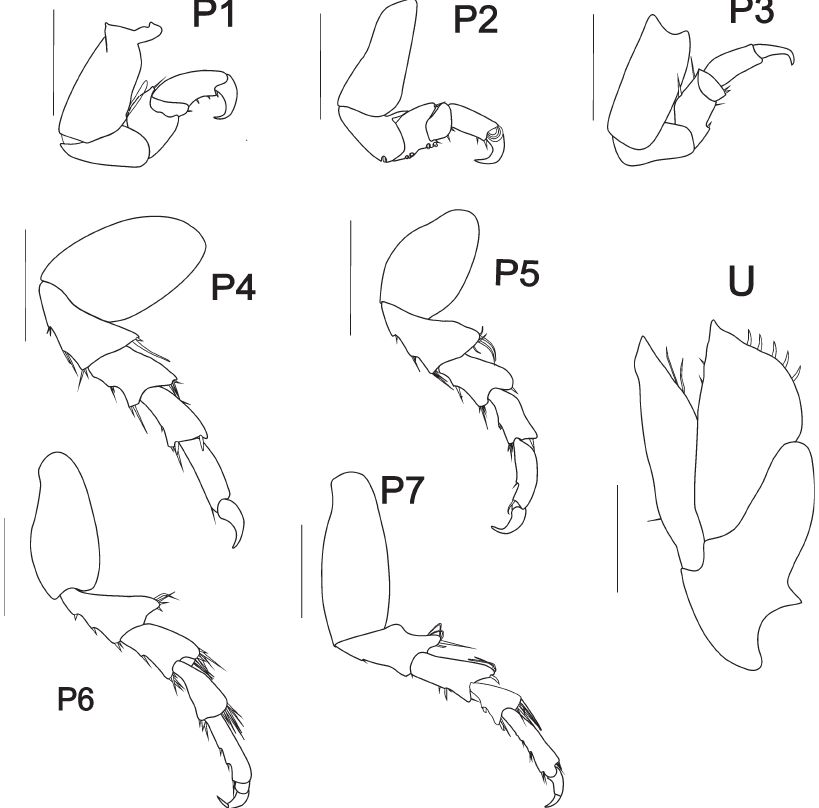
Figure 7. Excorallana lemoscastroi sp. nov., paratype male, 10 mm, (MOUFPE 118), pereopods and uropod. Scale = 1